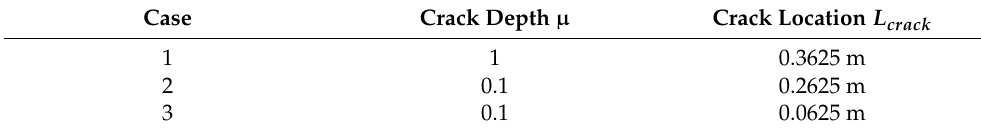
Table 2. Sets of parameters for the crack element.